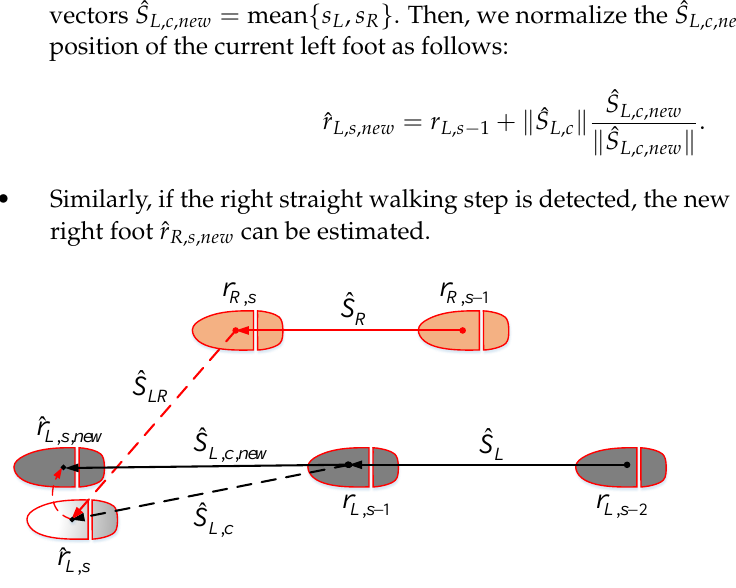
Figure 7. Straight detection for current left